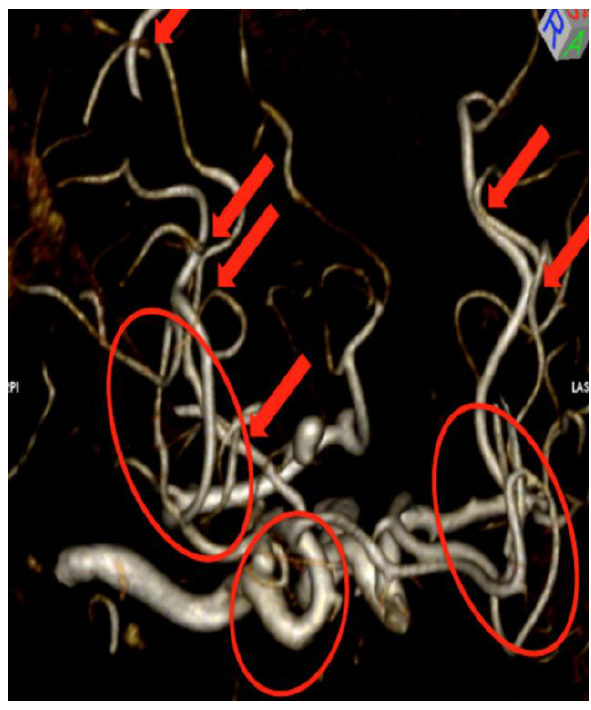
Figure 3. Magnetic Resonance Angiography (MRA) viewed with a volume rendering technique shows the cerebral vasculature with all other tissues removed. Note that there are multiple areas of overlapping blood vessels as indicated by the red arrows and the red ovals. No matter which way the volume rendering image is rotated, overlapping vessels will be seen, which limits evaluation. Additionally, computer processing of the images is performed including an apparent light source and shadowing, which can potentially cause interpretation